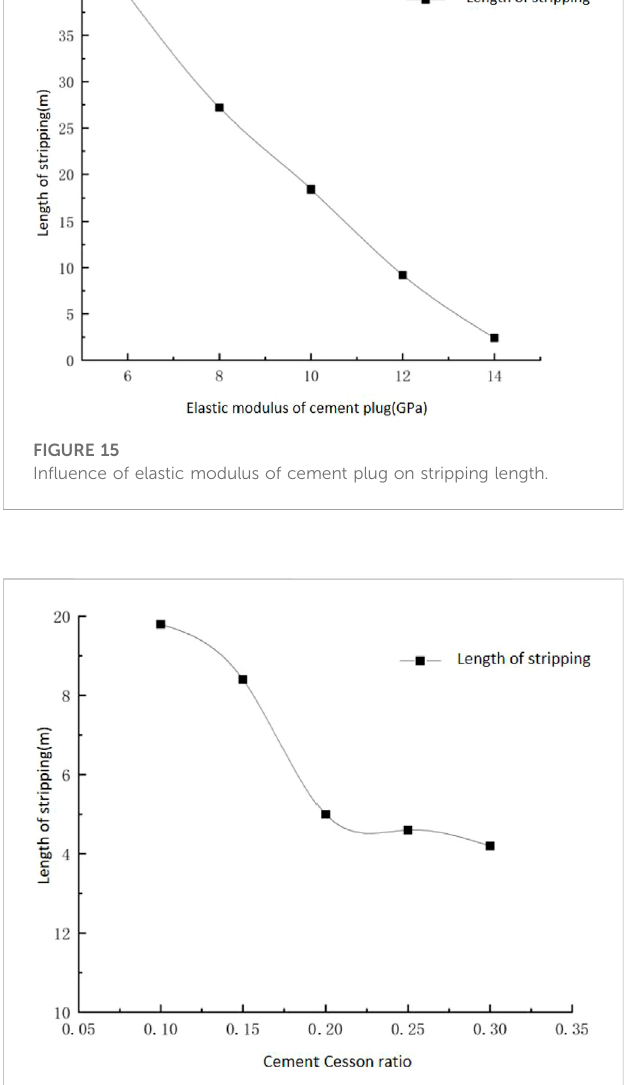
FIGURE 16 In fl uence of cement Poisson ’ s ratio on the length of